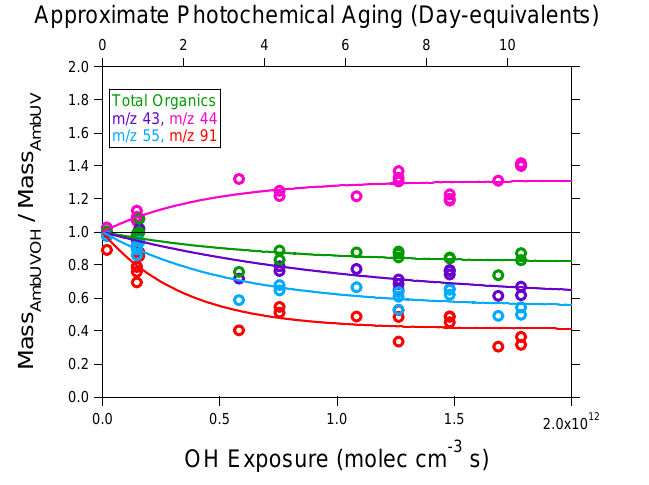
Fig. 6. Change in mass of selected organic m / z (43, 44, 55, and 91) and total organic mass as a function of OH exposure. Photo- chemical age is estimated assuming a mean OH concentration of 2 × 10 6 moleccm − 3 . Data is fitted to y =1+ a (1- e − kx ).